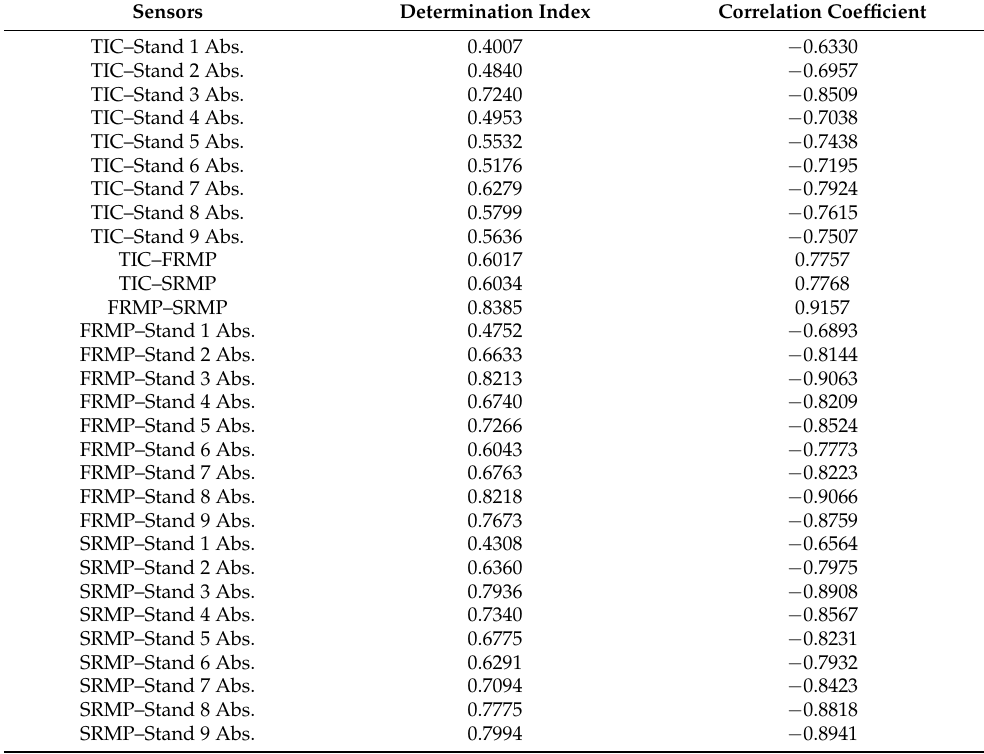
Table 5. Data analysis results ( original plant configuration) for the billets of the same steel quality and of the same diameter for the related finished